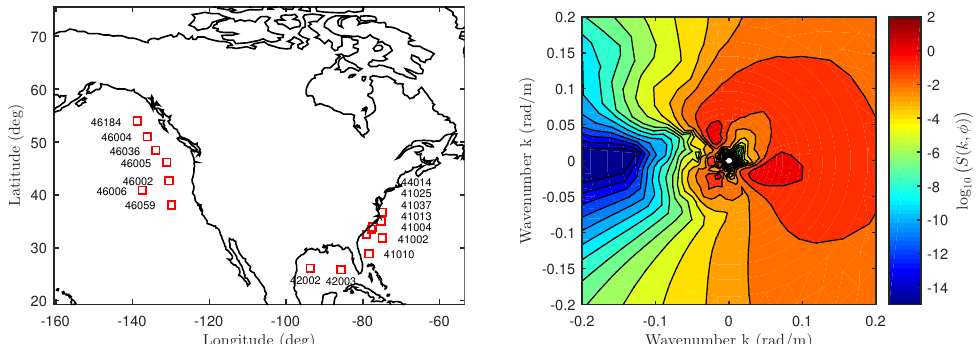
Figure 6. Buoy Data. ( Left ): Locations of the 16 buoys used. The buoy labels in the central Atlantic coast are arranged based on latitude such that top-most buoy corresponds to the top-most buoy label. ( Right ): 2D spectrum of Buoy 46006 on 14 June 2015 at 12:00:00 UTC in the up-cross-wind coordinate system. The associated wind speed is u 10 = 5.63 m/s from φ = 50.3 ◦